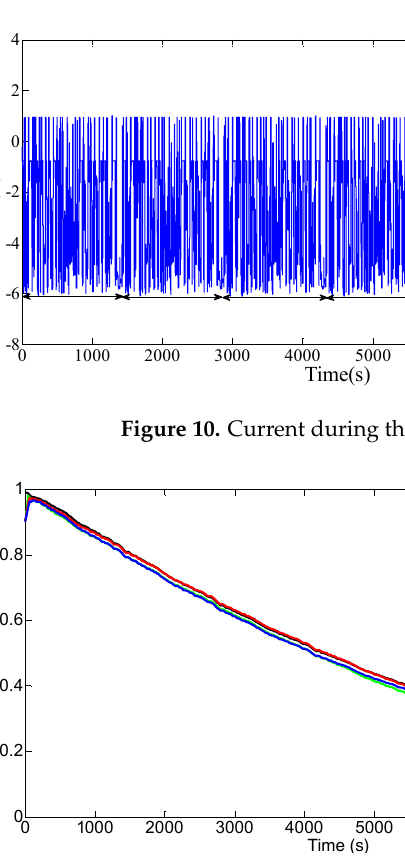
Figure 11. EKF, UKF, and ASRUKF SOC estimation results in the UDDS test.